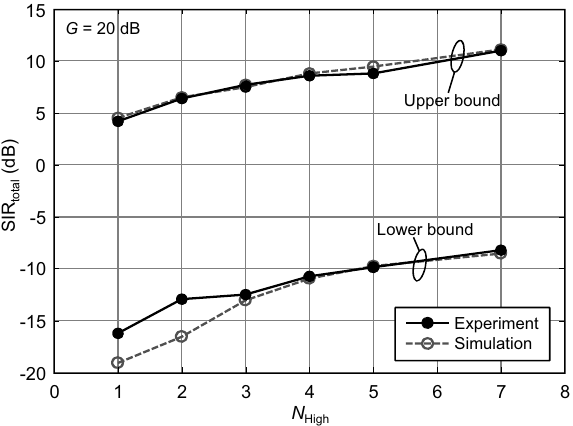
Figure 10. Operational SIR total range of the secondary system by number of high level subcarrier N High ( G = 20